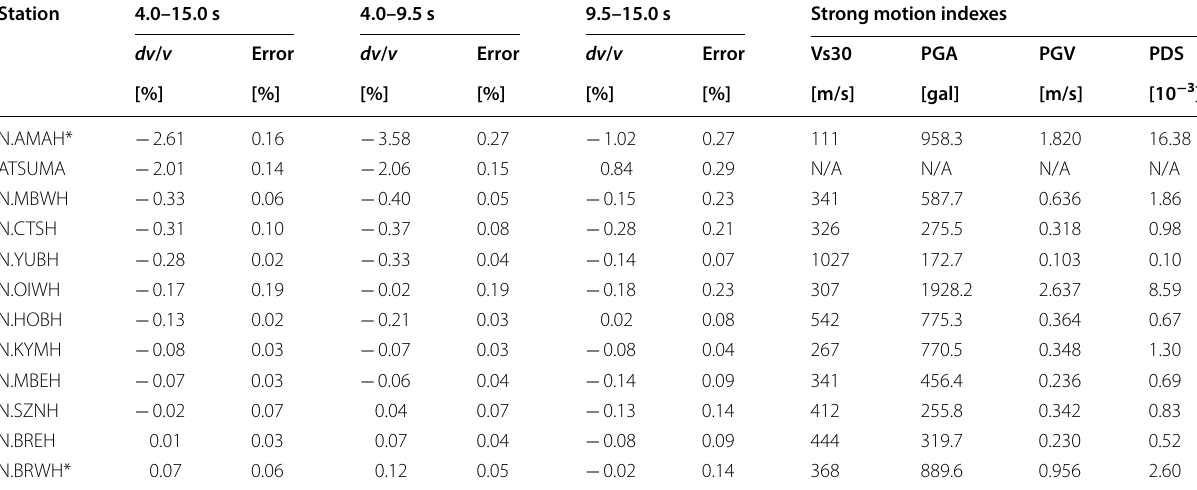
Table 1 Average values in dv/v and their standard deviations estimated from the three time windows, and computed indexes of strong ground motion, at each station Station